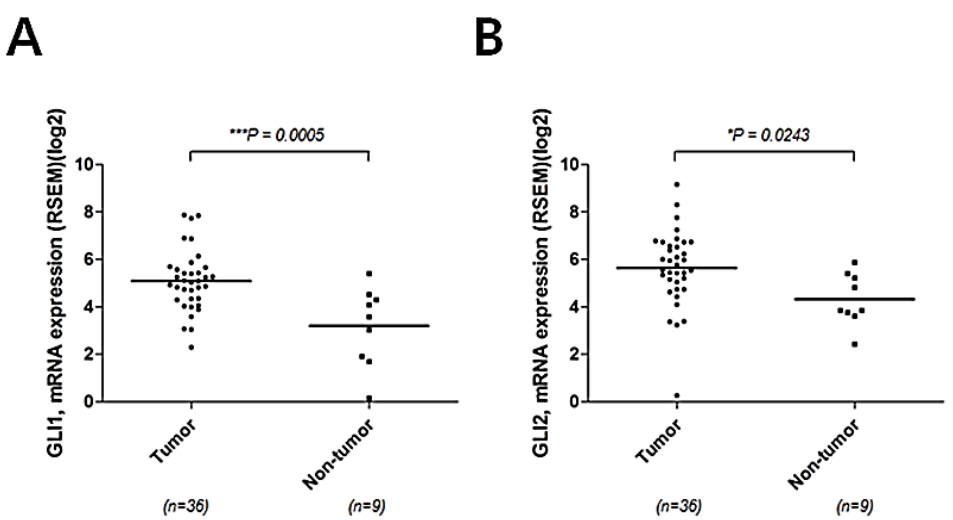
Figure 1. Activation of SHH signaling in human CCC. Expression levels of GLI1 ( A ) and GLI2 ( B ) in tumor and non-tumor tissues were compared using The Cancer Genome Atlas (TCGA).